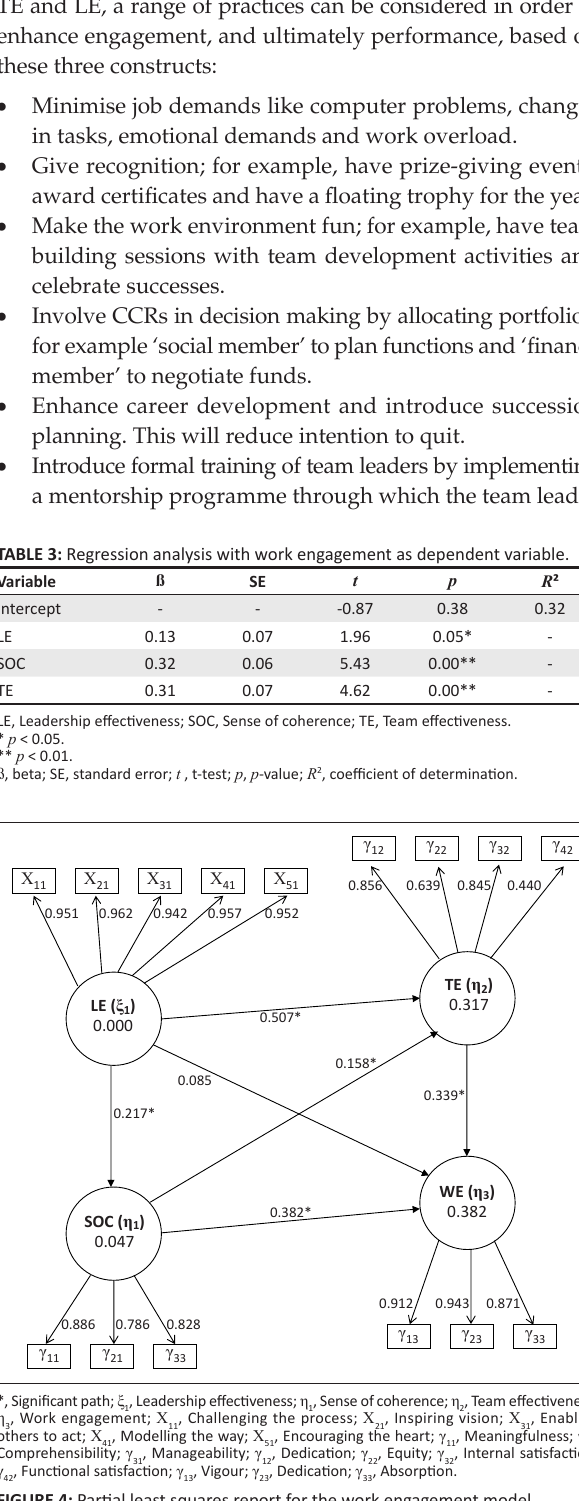
FIGURE 4: Partial least squares report for the work engagement